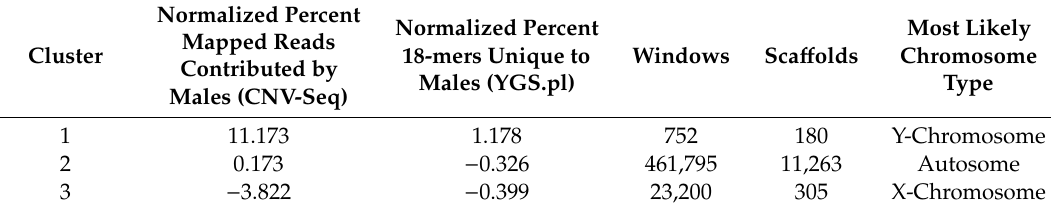
Table 5. Clusters identified with k -means clustering. The centers of the clusters identified by k -means clustering are based on a Cartesian plot of the two metrics. The chromosome type most consistent with each cluster’s position is indicated. As expected, because the scores are normalized, the centroid for the autosomes is at approximately (0,0), whereas the centroid for the X-chromosome is to the left of 0 (i.e., the normalized CNV-Seq score is negative), and the centroid for the Y-chromosome is to the right (i.e., the normalized CNV-Seq score is positive). Normalized Percent Normalized Percent Most Likely Mapped Reads 18-mers Unique to Windows Sca ff olds Chromosome Cluster Contributed by Males (YGS.pl) Type Males (CNV-Seq) 1 11.173 1.178 752 180 Y-Chromosome 2 0.173 − 0.326 461,795 11,263 Autosome 3 − 3.822 − 0.399 23,200 305